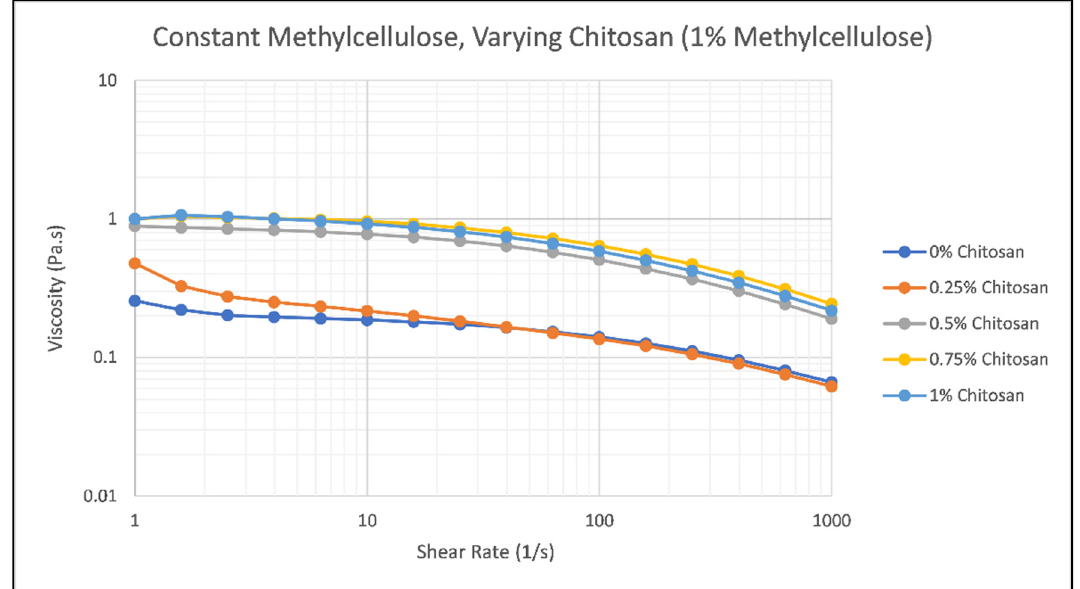
Figure 3. Effect of Chitosan Concentration on the viscosity of Samples 6 (blue), 7 (orange), 8 (gray), 9 (yellow), and 10 (green) as the shear rate increases from 1 to 1000 s − 1